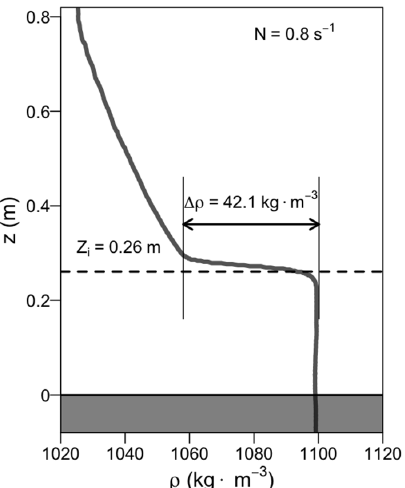
Figure 2. Example of a density profile for experiment 242. The depth of the mounting plate for the obstacles is indicated with a shaded area at the bottom of the plot.